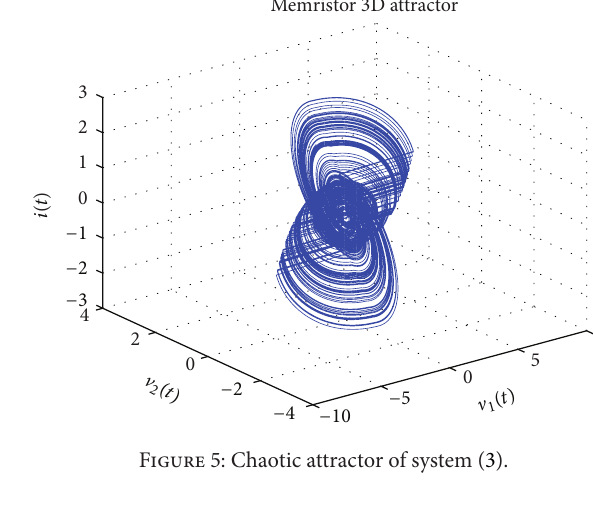
Figure 3: Chaotic attractor of system (3).